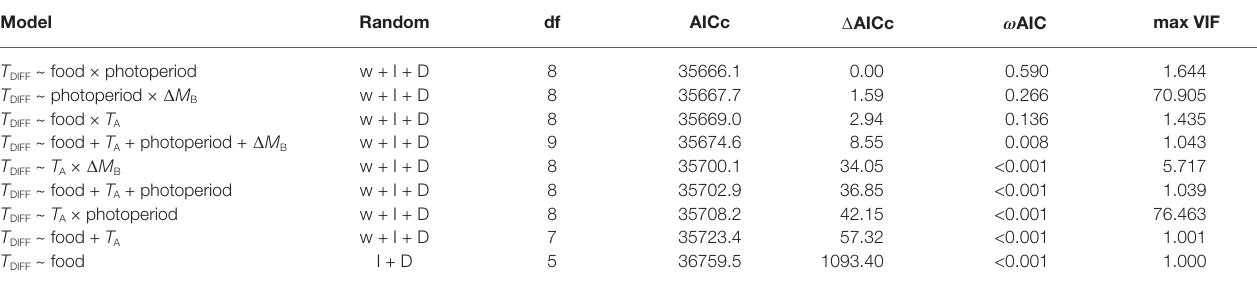
TABLE 2 | Multi-model selection results upon nine candidate models based on Akaike information criteria (AICc). Multicollinearity was tested using the maximum value of the variance inflation factor (VIF) for each model. Model